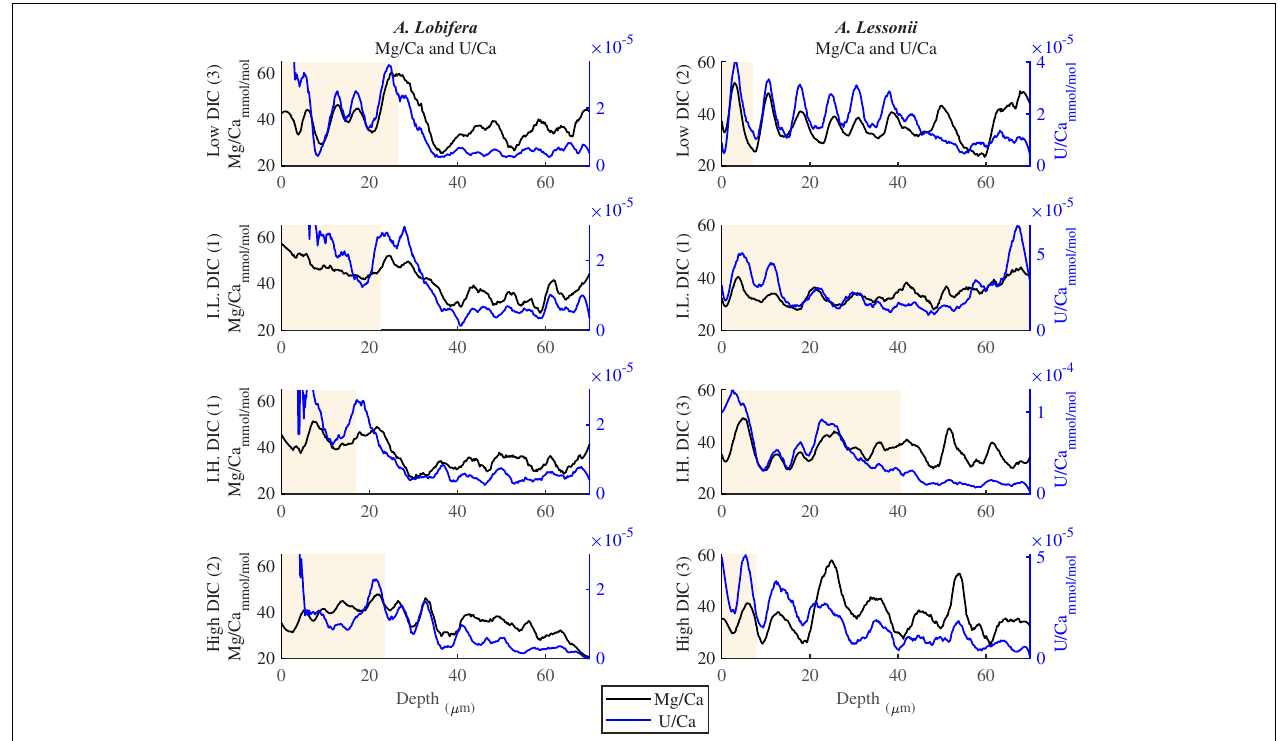
FIGURE 5 | U/Ca and Mg/Ca ratios in the knob profile of A. lessonii and A. lobifera for one selected specimen for the four DIC treatments (all the data are given in the Supplementary Material ). The two elements show similar cycles in both frequency and amplitude. In that respect, this is similar to the K/Ca ratio shown in Figure 4 . The DIC treatment did not affect the elemental